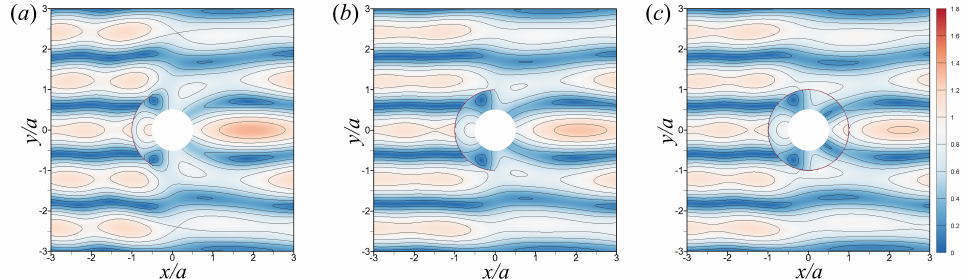
Figure 11. Distribution of the relative wave height for different values of γ with ka = 3, β = π /3, h / a = 1, k x / k = 0.5, U 0 = 0.4 m/s, G = 1, and α = π − γ /2: ( a ) γ = 2 π /3; ( b ) γ = π ; ( c ) γ = 2 π .